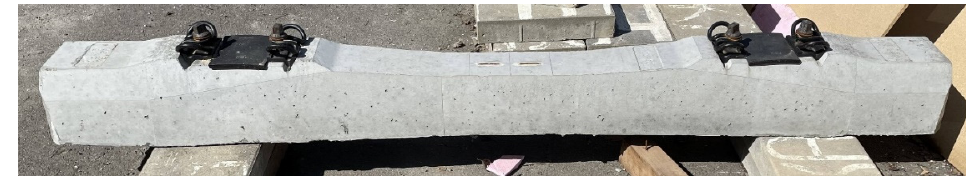
Figure 2. Investigated prestressed concrete sleeper.